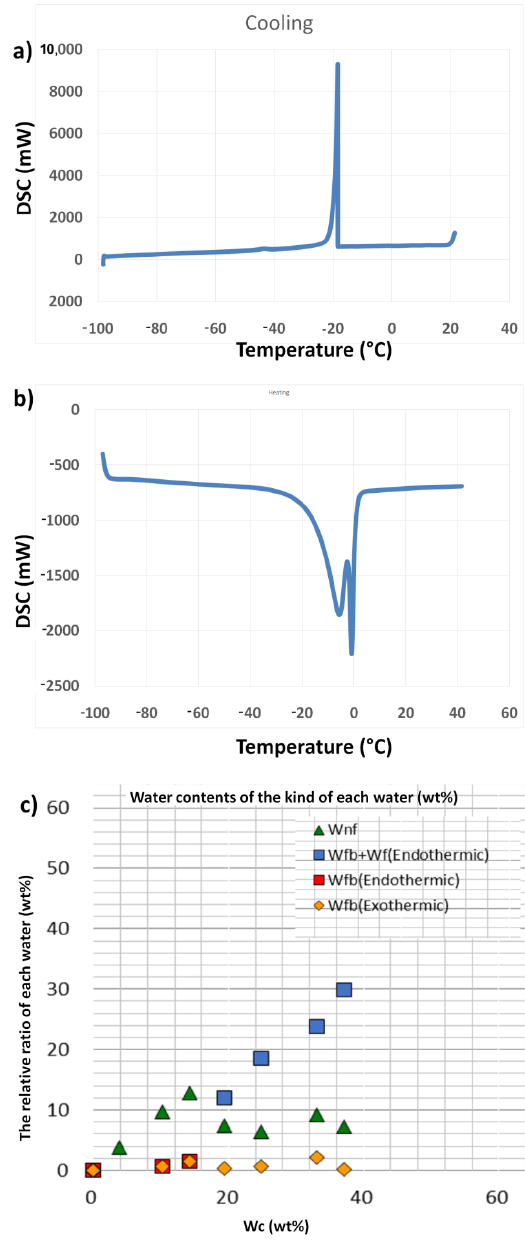
Figure 9. Water content of BGT10 sample determined by differential scanning calorimetry